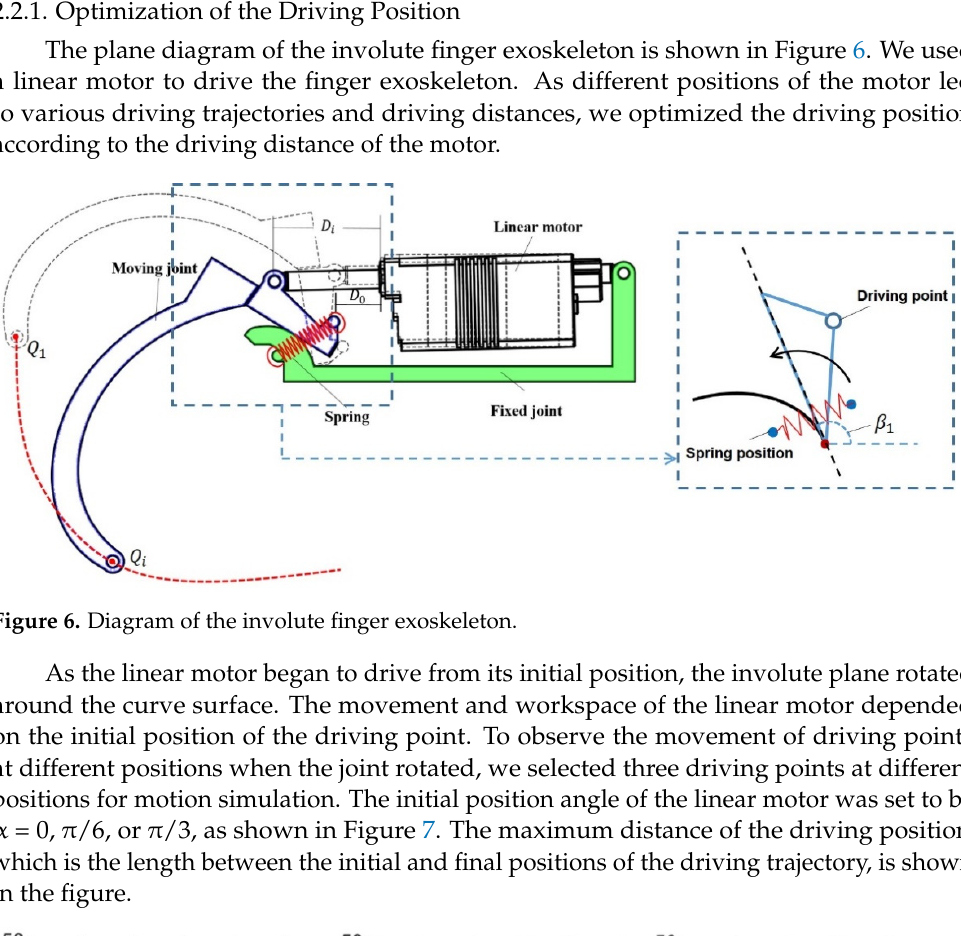
Figure 5. Design of an Involute Joint for the End-effect Finger. ( a ) Motion capture of the fingertip. ( b ) Optimization results for the involute joint.